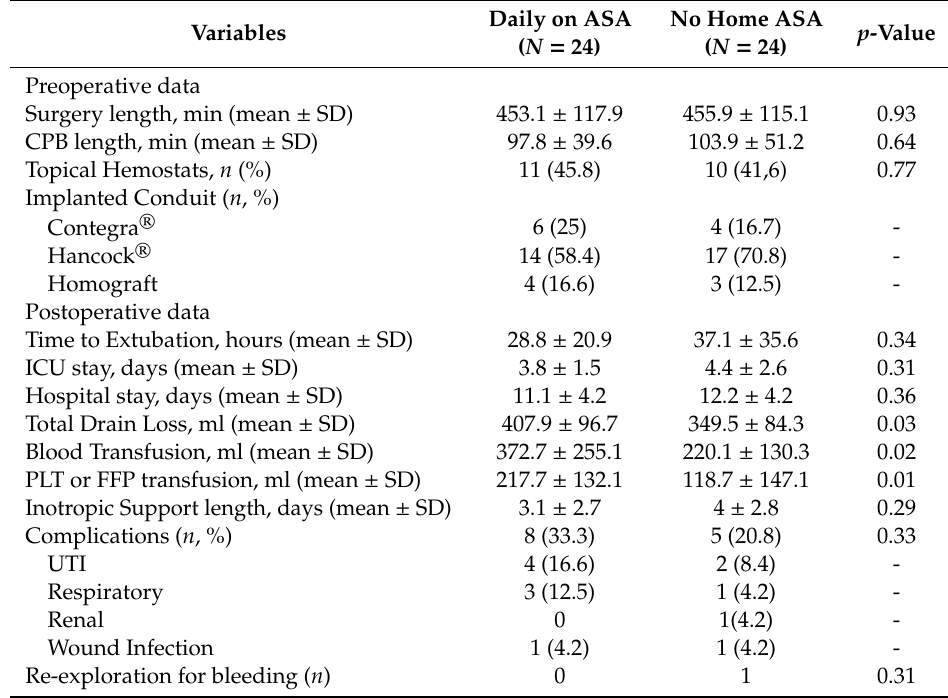
Table 3. Intraoperative and Postoperative